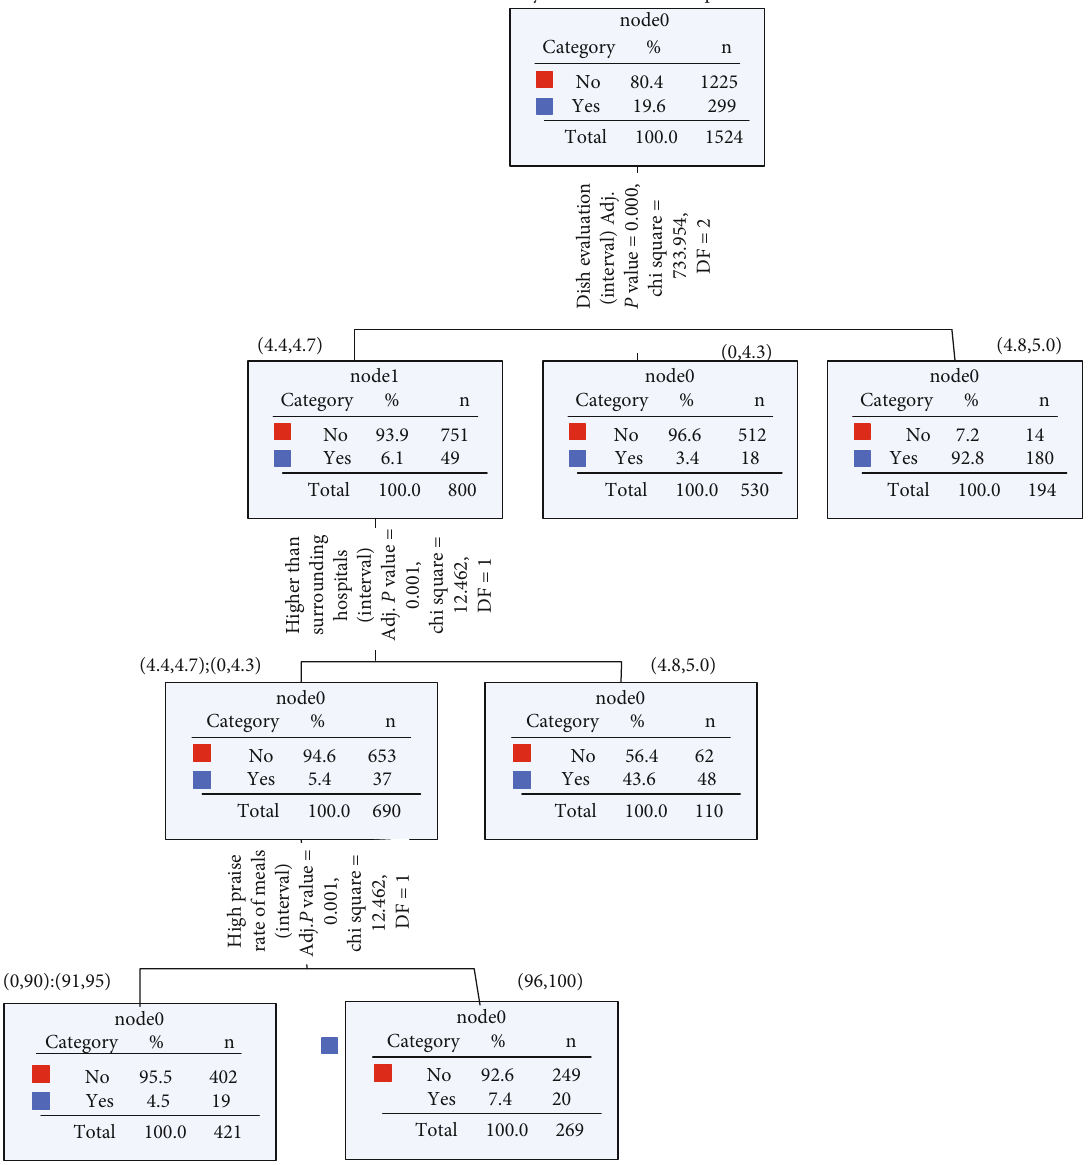
Figure 8: Schematic diagram of the training sample decision